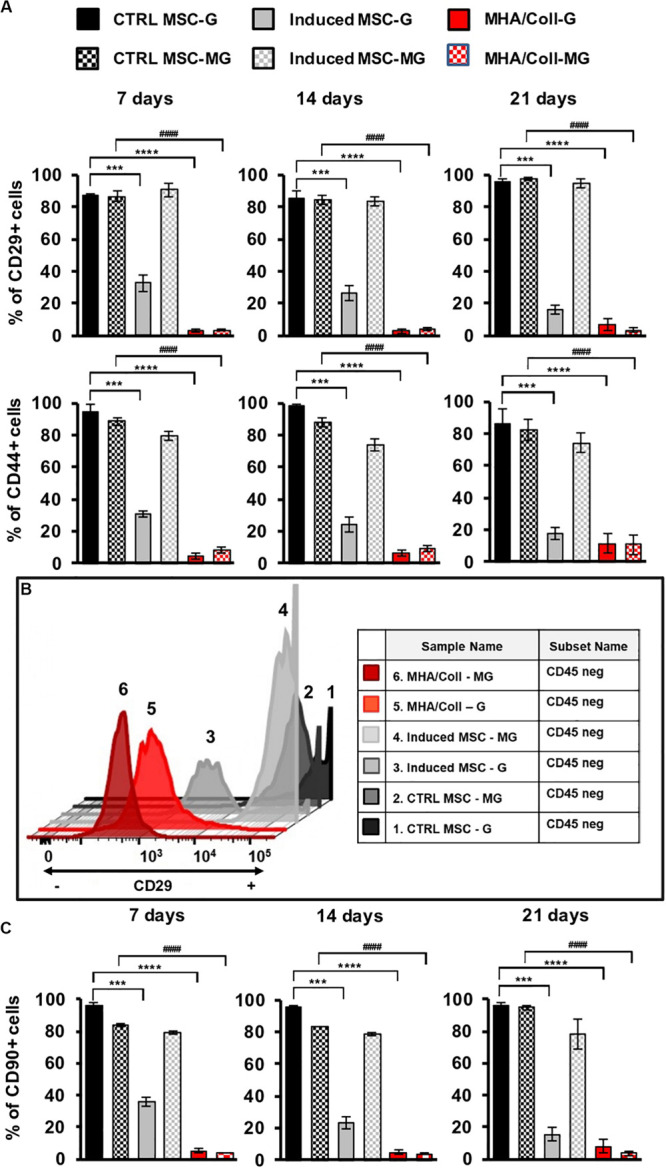
MHA/Coll-induced hBM-MSCs differentiation under MG condition. hBM-MSCs osteogenic differentiation was investigated in MHA/Coll scaffolds after 7, 14, and 21 days under G or MG conditions. The levels of the differentiation markers CD29 and CD44 were evaluated by flow cytometry. Uninduced-MSC (black) and induced-MSC (gray) were used as negative and positive control, respectively, for induced hBM-MSCs cultured on scaffolds (A). Differentiation plot displaying hBM-MSCs, which are negative for CD45 marker, and differentiated cells, which showed the loss of the differentiation marker CD29. Uninduced-MSC (black) and induced-MSC (gray) were used as negative and positive control, respectively, for induced hBM-MSCs cultured on scaffolds (B). Cell differentiation of hBM-MSCs cultured on MHA/Coll scaffolds was investigated after 21 days evaluating the expression of CD90 as a differentiation marker toward osteogenic lineage (C). The results are expressed as % of positive cells and are the average of three independent experiments. Significant differences: ***p < 0.001 and ****p < 0.0001, vs. ctrl-MSC under G condition; ####p < 0.0001, vs. ctrl-MSC under MG condition (Two-way ANOVA).